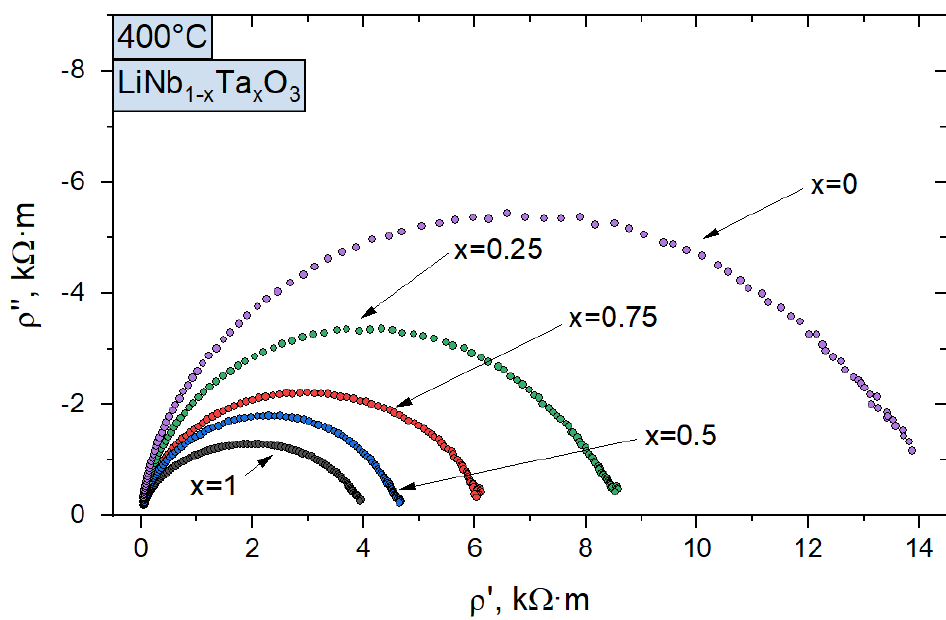
Figure 12. Complex impedance of pressed LiNb 1 − x Ta x O 3 samples measured at 400 °C.